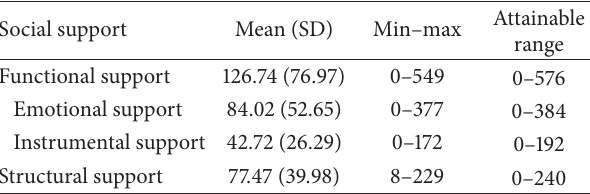
Table 5: Perceived social support of participants in study.